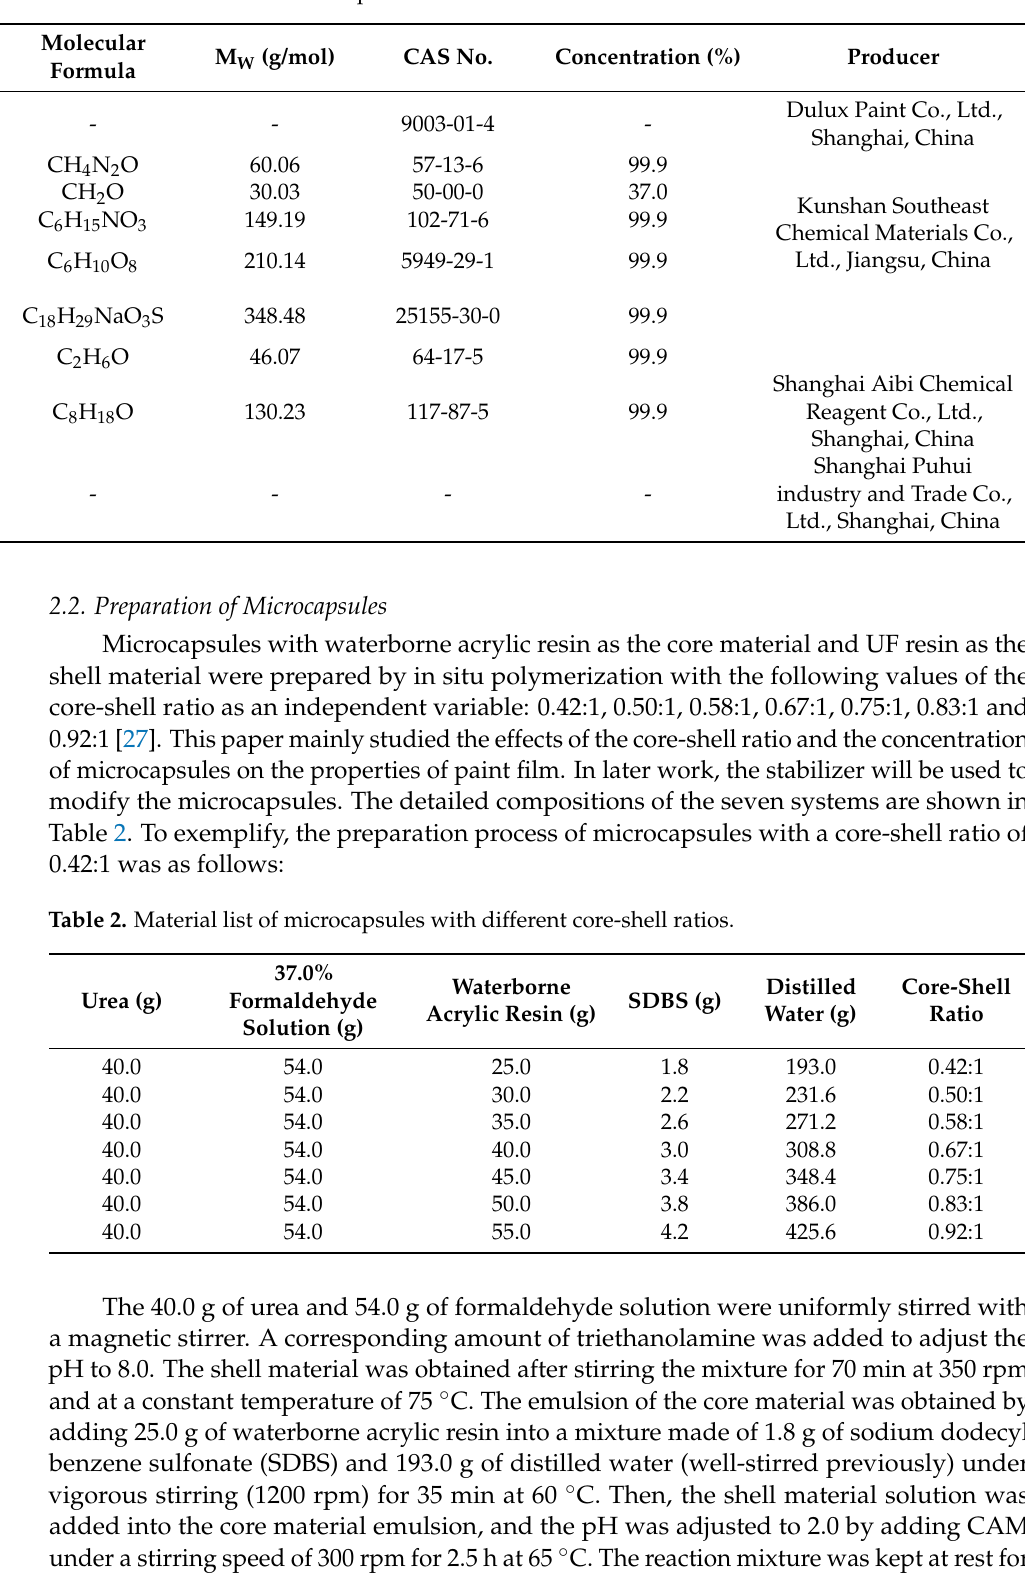
Table 1. List of experimental materials.